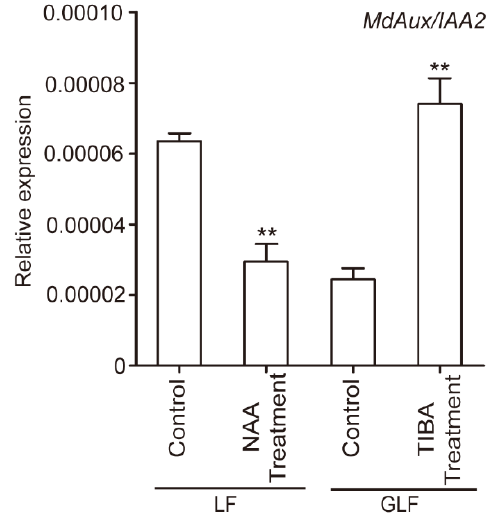
Figure 2. The influence of auxin and TIBA on the MdAux/IAA2 gene in fruit. MdActin gene (EB136338) was used as endogenous control. ** Significant differences ( p < 0.05, Student’s t -test). Error bars indicate the standard deviation (SD) of the three biological replicates. LF: Longfeng; GLF: Grand Longfeng.